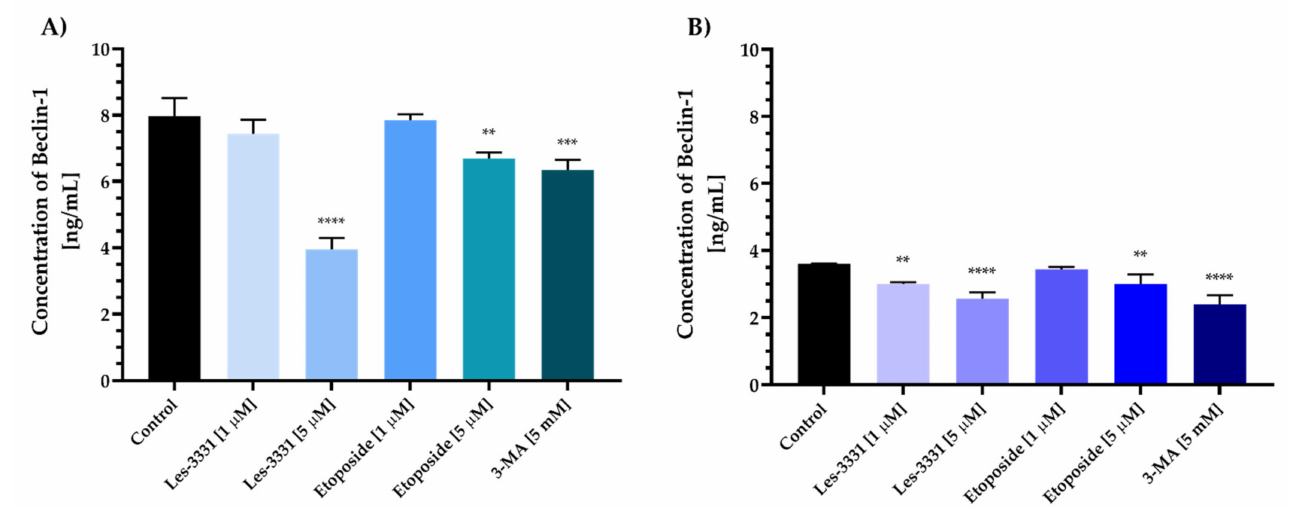
Figure 10. The concentration of Beclin-1 in MCF-7 ( A ) and MDA-MB-231 ( B ) human breast cancer cells after 24 h incubation with Les-3331 and reference drug (etoposide) at 1 µ M and 5 µ M concentration. As a positive control, 3-Methyladenine (3-MA), a known autophagy inhibitor, in 5 mM concentration was used. Mean ± SD from three independent experiments performed in duplicate is presented. Statistical significance was calculated using one-way ANOVA with Bonferroni multiple comparison test. Differences were considered statistically significant at: ** ( p ≤ 0.01), *** ( p ≤ 0.001), **** ( p ≤